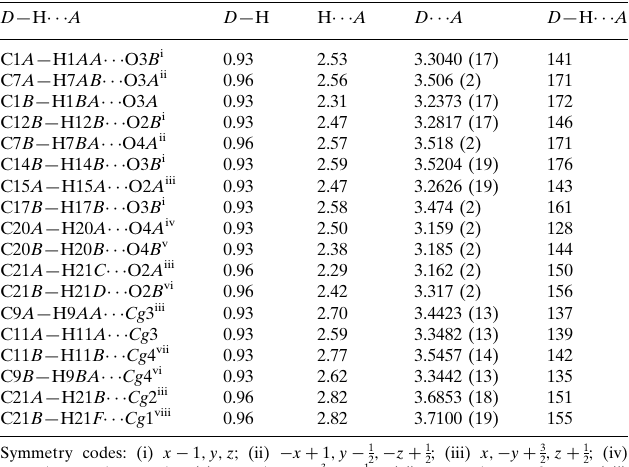
Hydrogen-bond geometry (A˚ , (cid:4)